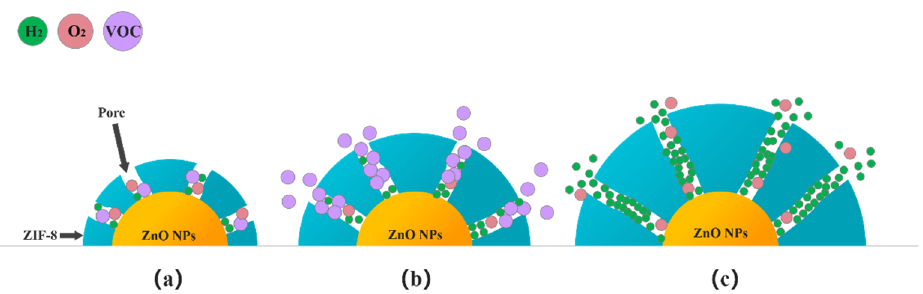
Figure 16. Schematic diagram of gas passing through the ZIF-8 films of different thicknesses: ( a ) Thinner; ( b ) Appropriate; and ( c ) Thicker.